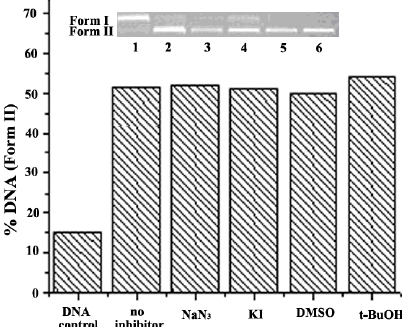
Figure 8. Histograms representing cleavage of pUC19 plasmid DNA (0.008 µg/µL) by compound 1a with different typical radical scavengers (6.25 × 10 − 7 mol/L, pH = 8.0). Lane 1: DNA control, Lane 2: no inhibitor, Lane 3: NaN 3 , Lane 4: KI, Lane 5: DMSO, Lane 6: t -BuOH.